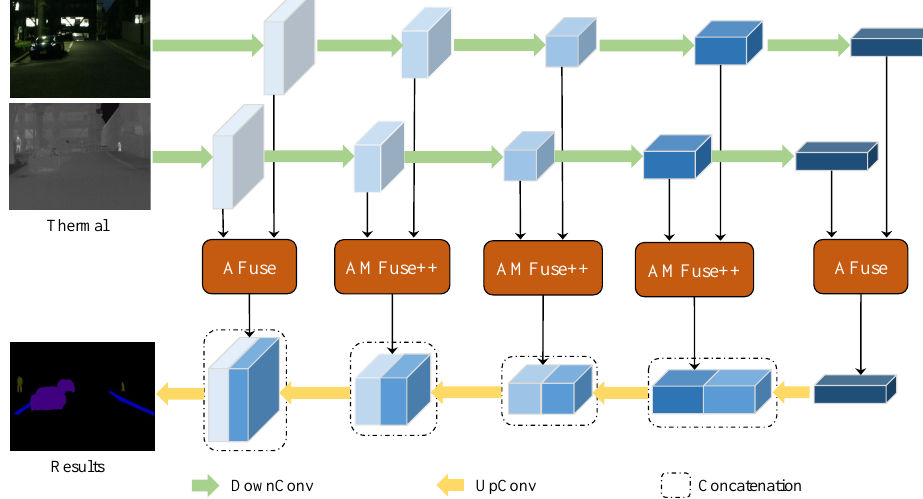
Figure 2. The outline of our framework for multi-spectral semantic segmentation, which mainly consists of two components: the encoder–decoder UNet-style framework and the proposed AM- Fuse modules. The encoder–decoder UNet-style framework includes two independent DownConv (downsampling+convolution) encoders, respectively, for RGB and thermal images, and one UpConv (upsampling+convolution) decoder for semantic segmentation to restore the desired resolution.